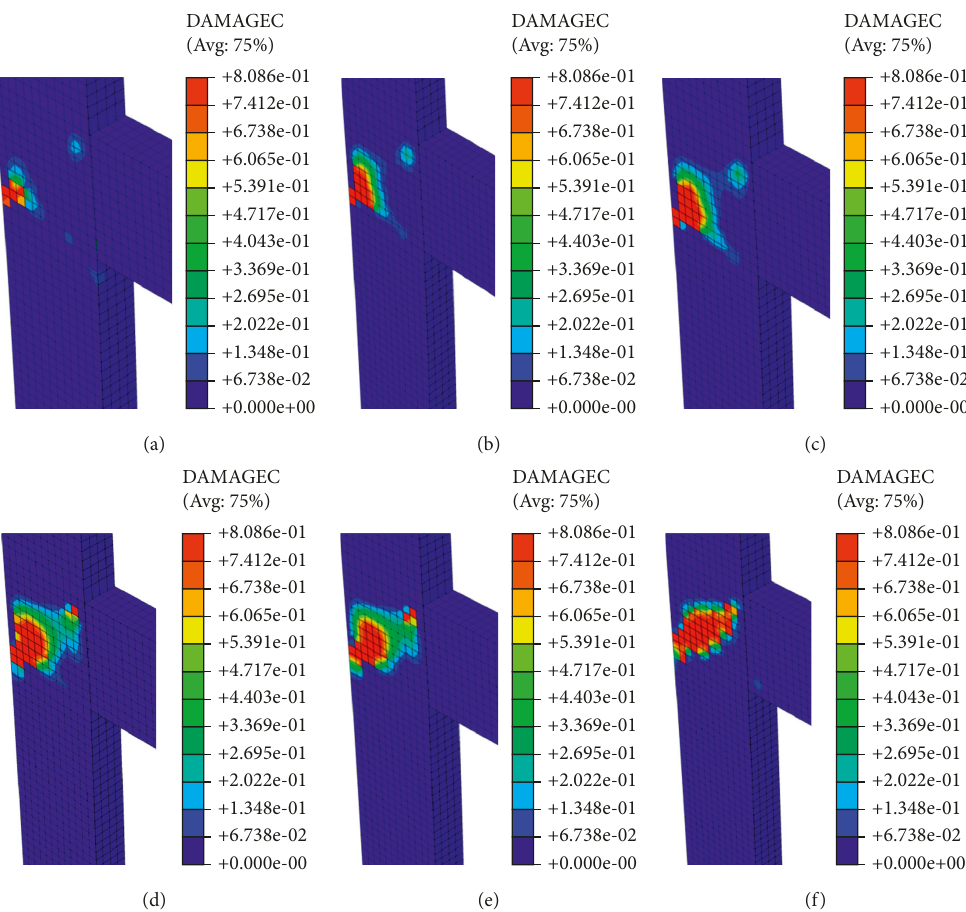
Figure 16: Concrete compression damage for specimens with various axial load ratios: (a) G1M0, no axial force; (b) G1M1, 0.1; (c) Referential, 0.133; (d) G1M2, 0.26; (e) G1M3, 0.3; and (f) G1M4, 0.6.